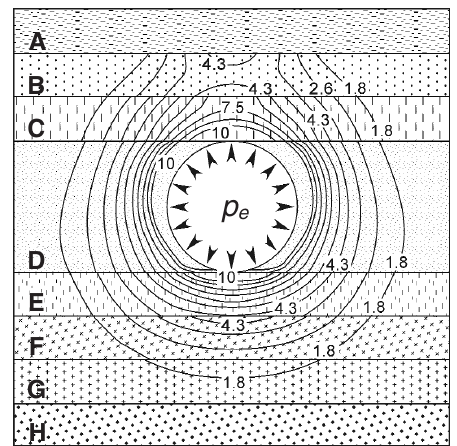
Fig. 16. Boundary-element model showing the con- tours, in MPa, of the maximum principal tensile stress σ 3 around a magma chamber in a layered crust of a rift zone or a volcanic edifice. The chamber is subject to magmatic excess pressure p e = 10 MPa, similar to the laboratory tensile strengths of common rocks. The stiff- nesses of the host-rock layers, also based on laboratory measurements (Hansen et al. , 1998; Bell, 2000; Nilsen and Palmstrom, 2000), are as follows: A = 5 GPa; B = 20 GPa; C = 30 GPa; D = 50 GPa; E = 70 GPa; F = 80 GPa; G = 90 GPa; and H = 100